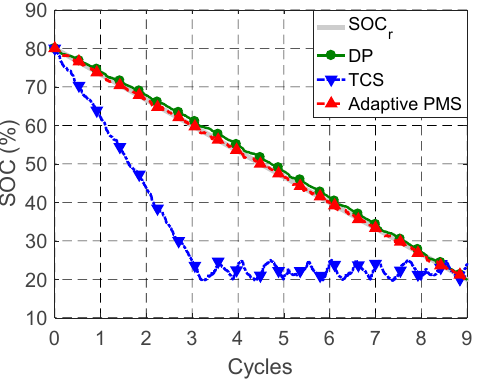
Figure 18. SOC responses for nine UDDS cycles. Table 4. Comparison of TCS, adaptive PMS and DP for 10 NEDC.